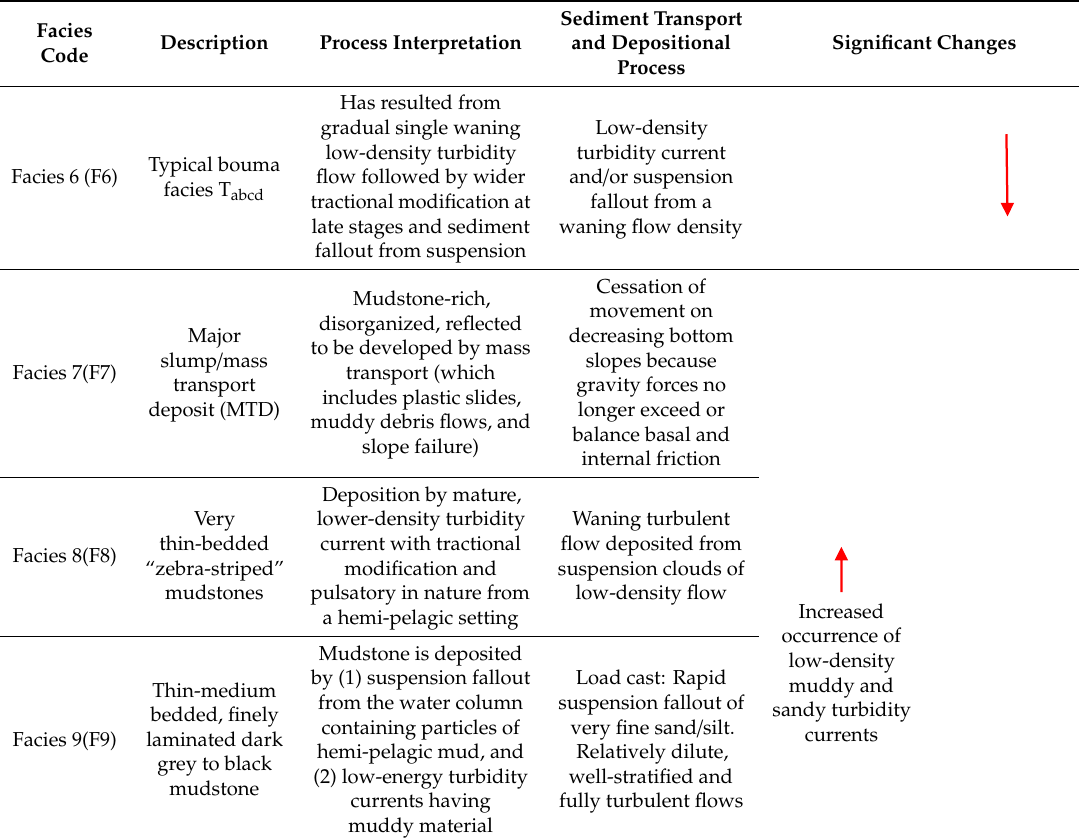
Table 2. TOC (wt.%) content along with Rock-Eval pyrolysis of black shale from the Semanggol